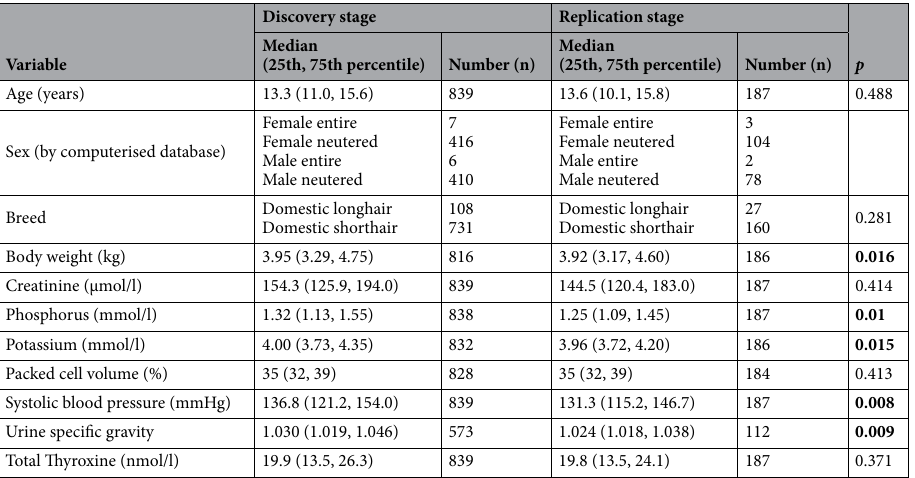
Table 1. Baseline signalment and clinicopathological data for cats included in the quantitative association with Log creatinine in the discovery and replication stages. P ; statistical significance comparing baseline parameters for discovery and replication stage for cats included in quantitative association analysis with LogCreat (P-values in bold if P < 0.05).